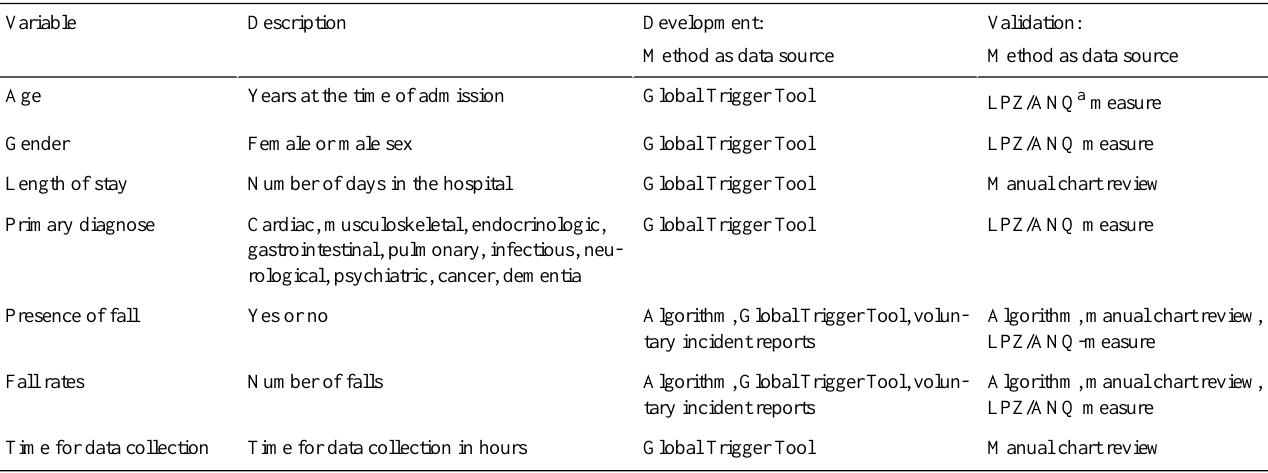
Table 1. Variables of the algorithm development and validation